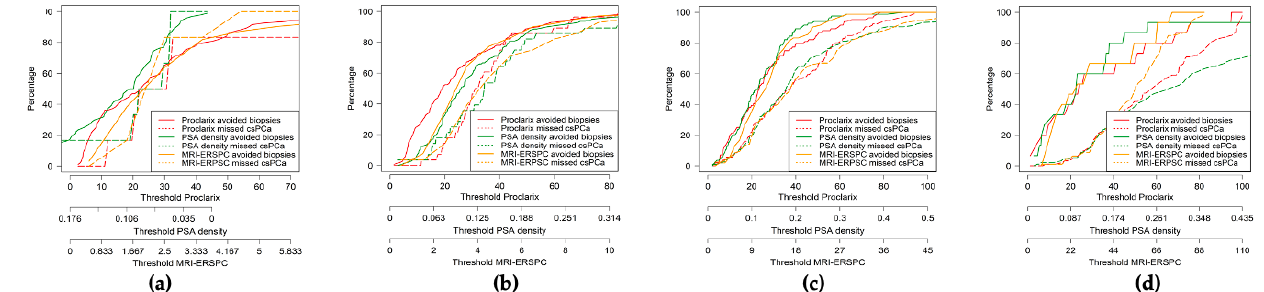
Figure 3. Clinical utility of Proclarix, PSAD, and MRI-ERSPC model for csPCa detection regarding PI-RADS categories. PI-RADS < 3 ( a ), PI-RADS 3 ( b ), PI-RADS 4 ( c ), and PI-RADS 5 ( d ).